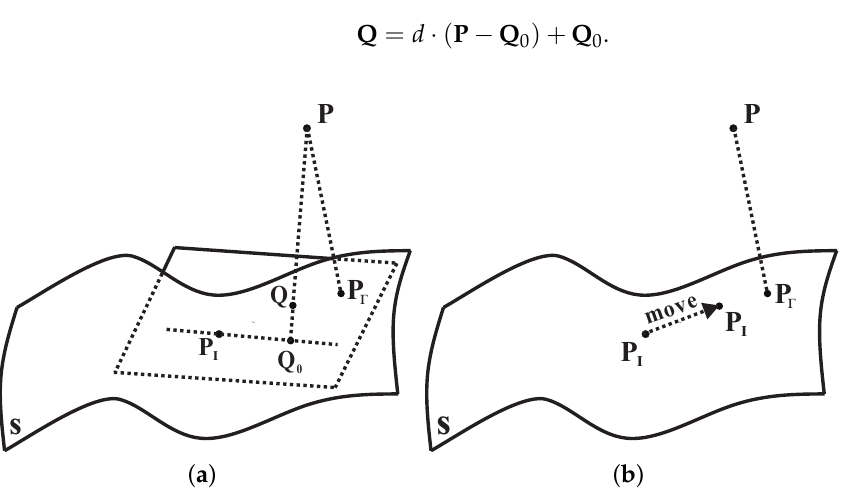
Figure 3. The complete graphic demonstration of Algorithm 2. ( a ) Computing the foot-point Q of Equation (14); ( b ) Moving the iterative point P I to the close position of the orthogonal projection point P Γ